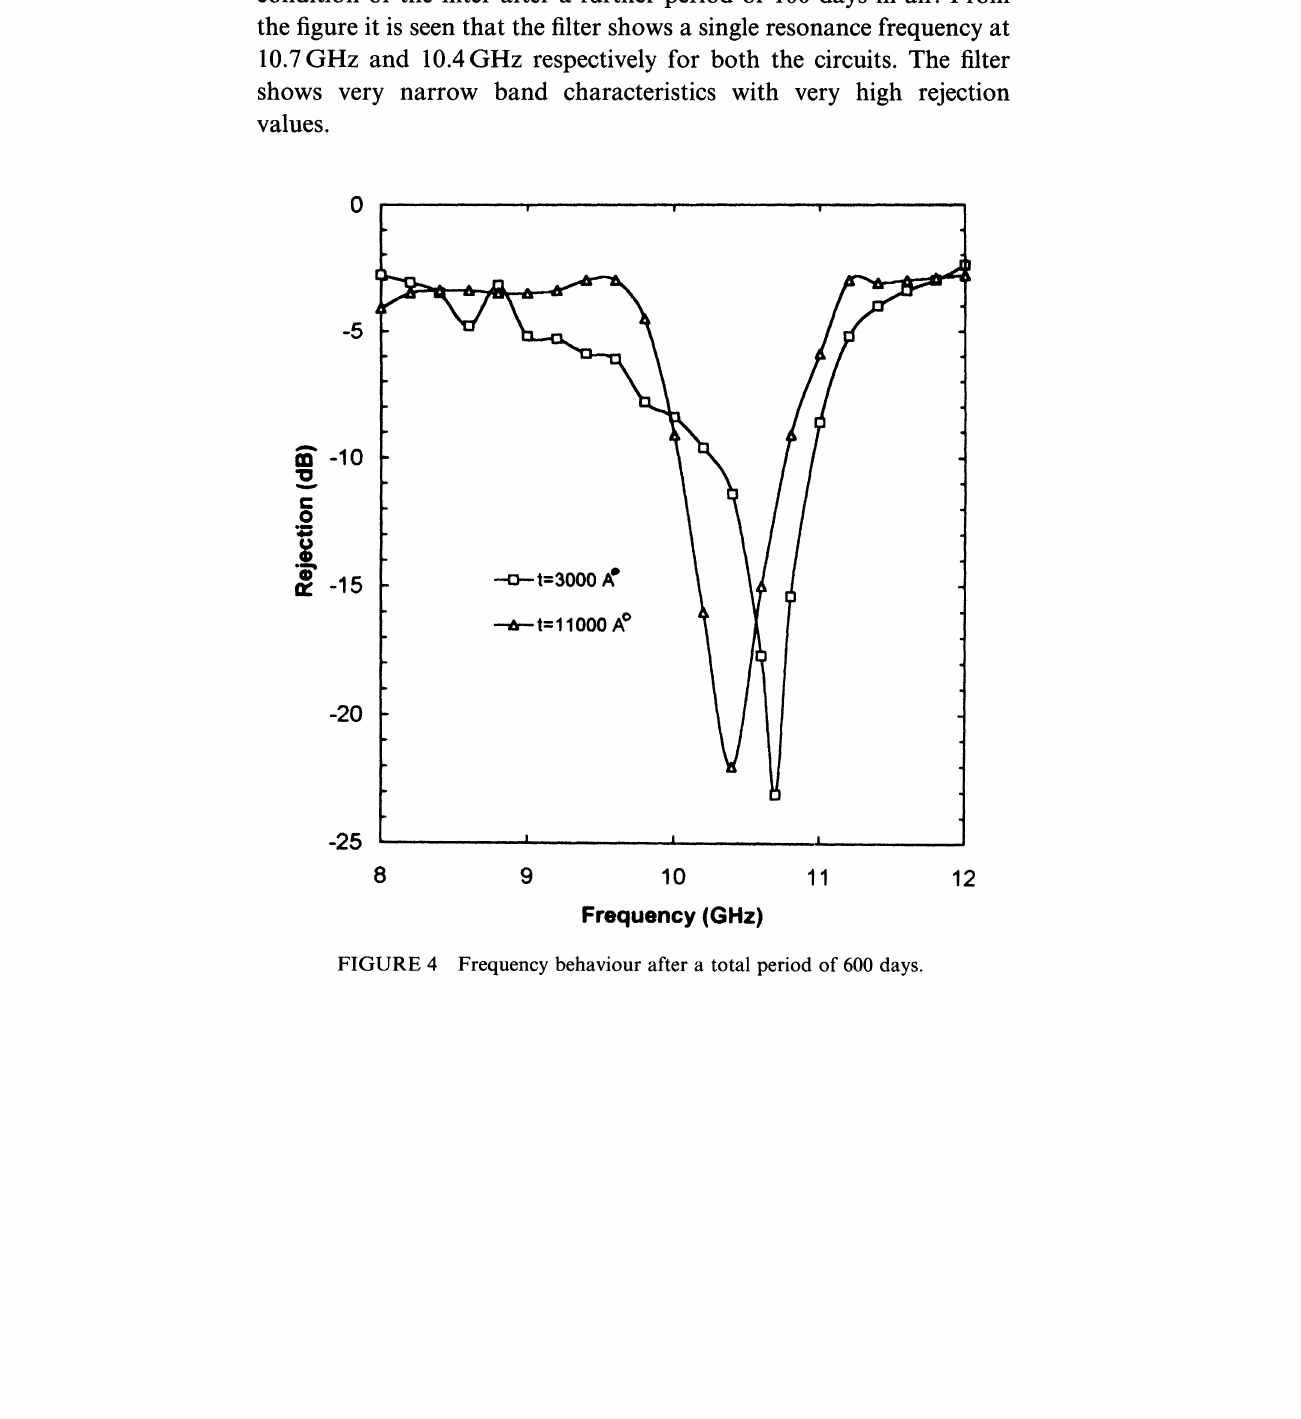
FIGURE 4 Frequency behaviour after a total period of 600